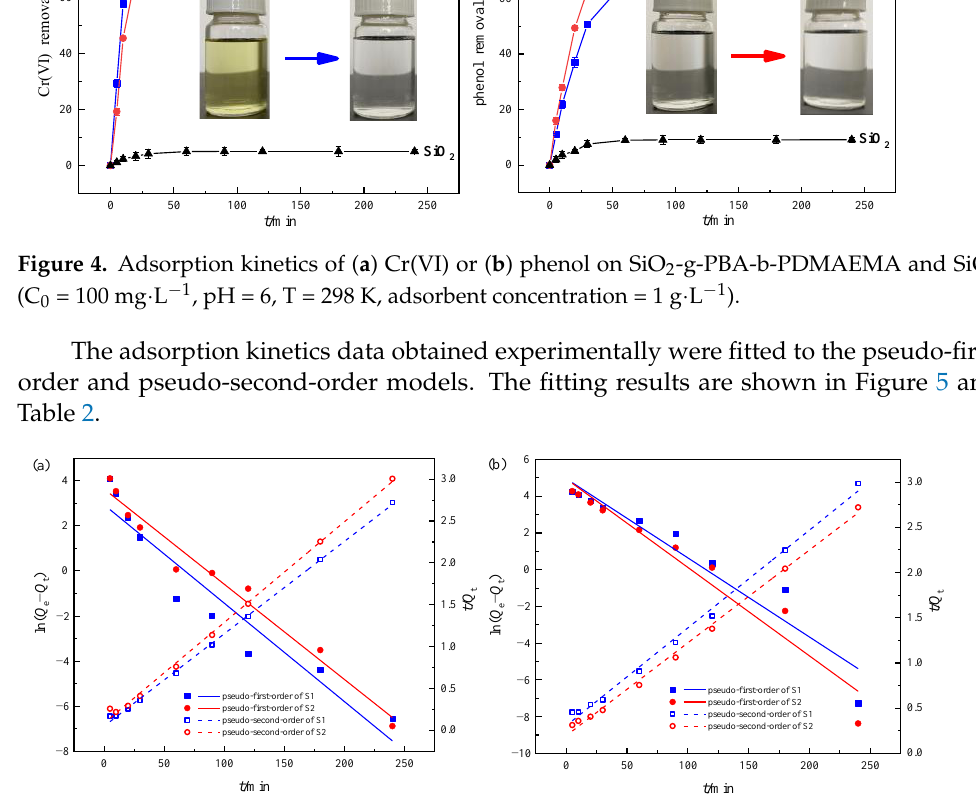
Figure 5. Fitting curves of adsorption kinetics for ( a ) Cr( Ⅵ ) and ( b ) phenol on SiO 2 -g-PBA-b- PDMAEMA. Table 2. Fitting parameters of adsorption kinetics.